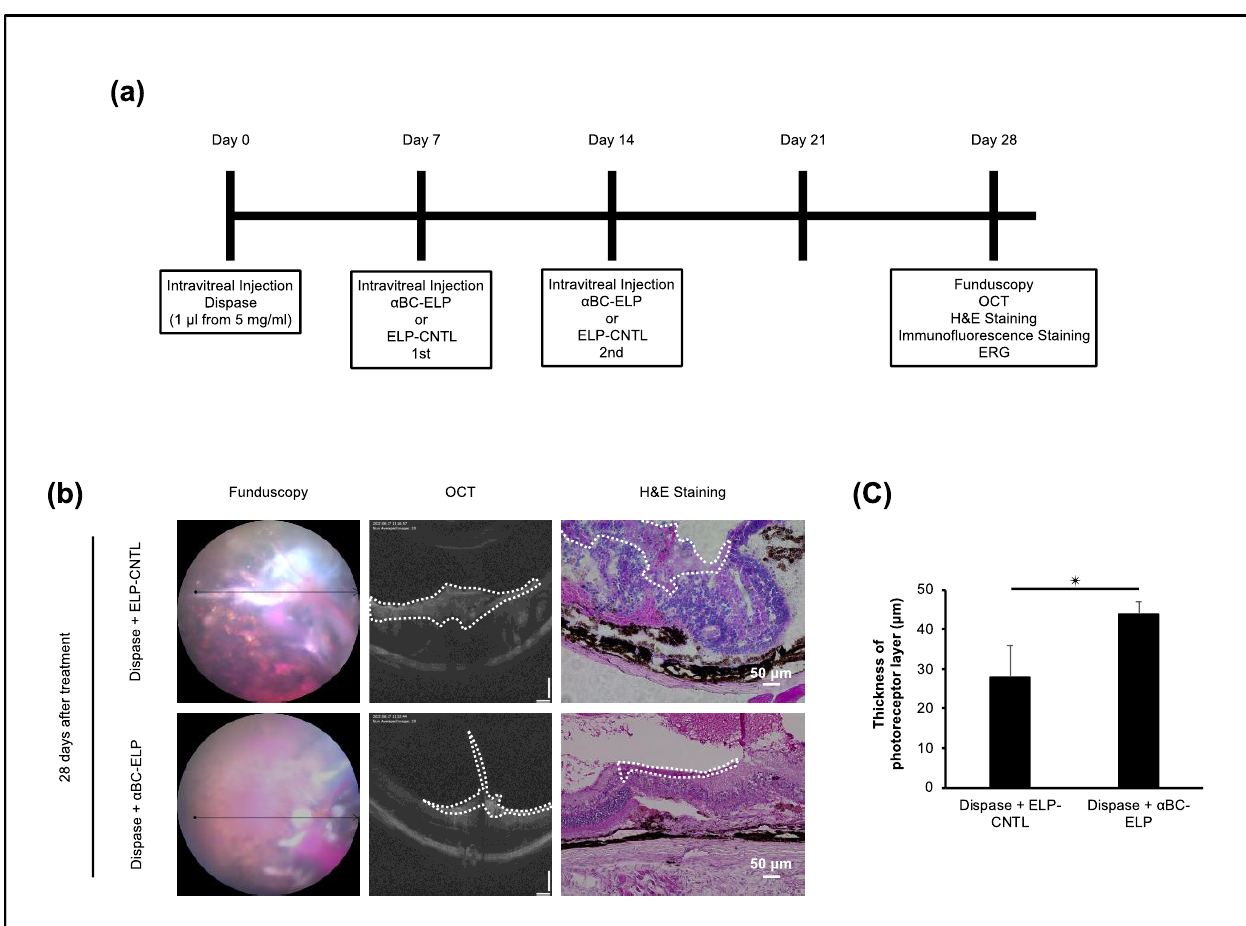
Figure 8. Effect of αBC -ELP in dispase-induced PVR in mouse. Mice were injected with a single intravitreal dose of dispase (1 μL, 5 mg/mL) on day 0. On days 7 and 14, αBC -ELP (CrySI, 1 μL from 21 8 μM) or Control ELP (SI) was administered intravitreally. On day 28, fundus, OCT images, and ERG data were gathered. At the end of the procedure, mice were euthanized, and retinal sections were processed for H&E and immunostaining. ( a ) Experimental scheme. The ELP preparations for α -BC-ELP and ELP-CNTL are also referred as CrySI and SI, respectively. ( b ) Fundus, OCT images, and H&E staining showed that mice treated with αBC -ELP had less proliferative membrane area and decreased retinal layer structure disruption compared to the dispase + ELP-CNTL group ( b ) The area enclosed by the white dotted line in OCT and H&E staining represents the PVR membrane. ( c ) Quantification of the photoreceptor thickness. αBC - ELP: αB crystallin -Elastin-like peptide. Scale bar : 5 0 μm. * p < 0.05, n = 5.